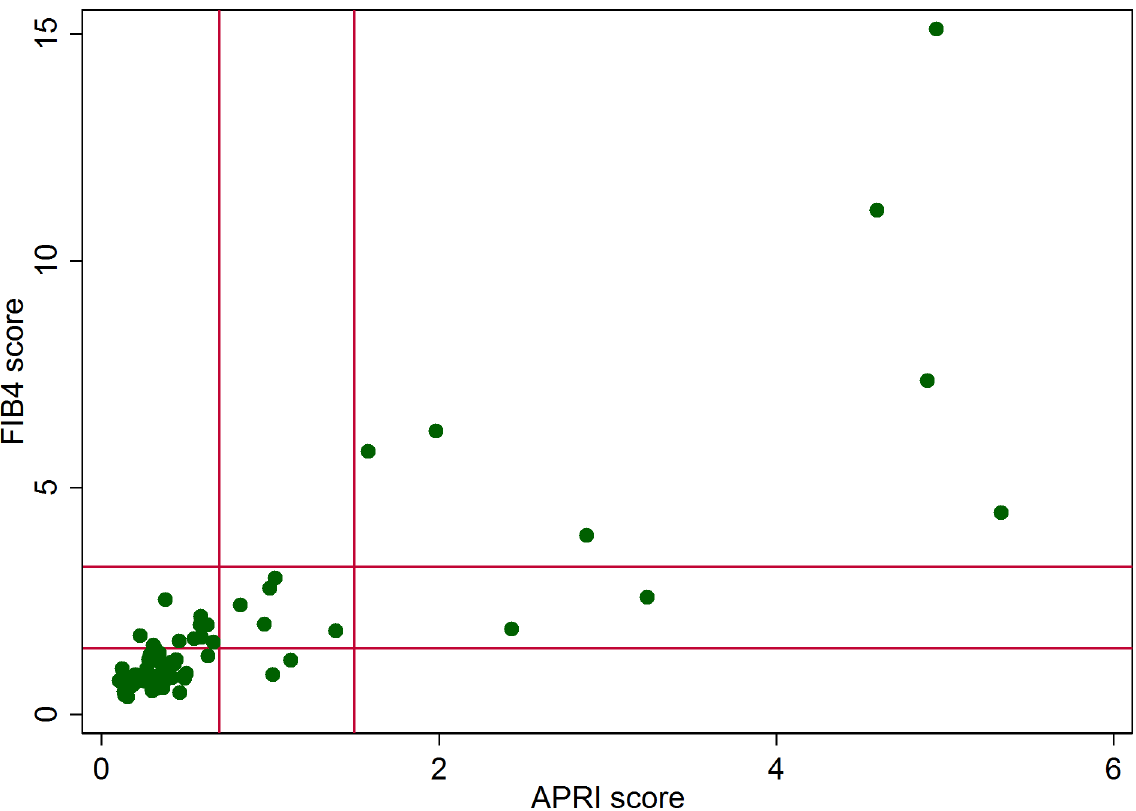
Fig 1. Comparison of APRI and FIB4 scores in HCV-RNApositive individuals. The vertical and horizontal lines indicate the cut- off points for significantfibrosis for APRI and FIB4 scores, respectively.Two cut-off points are presented: APRI (cid:21) 0.7 and FIB4 (cid:21) 1.45 (high sensitivity and low specificity) and APRI (cid:21) 1.5 and FIB4 (cid:21) 3.25 (low sensitivity and high specificity).